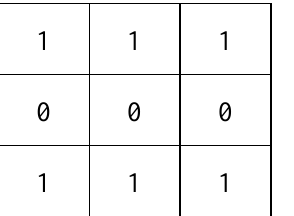
Figure 3. Examples of mask for opening or